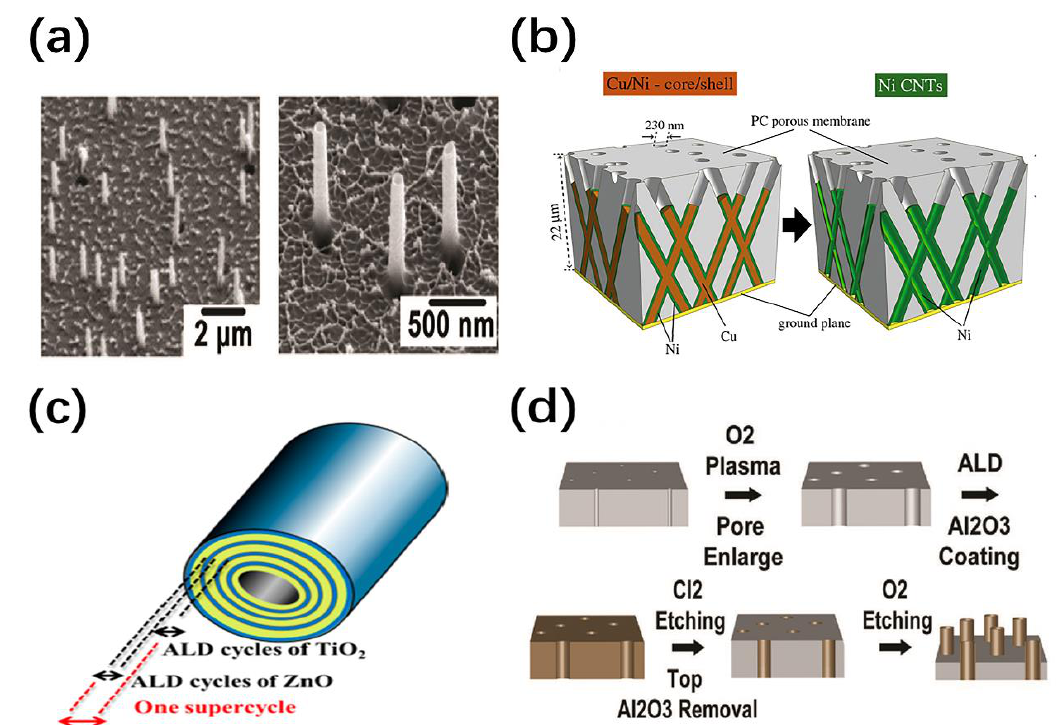
Figure 2. ( a ) SEM image of nanowires array [40]; ( b ) schematic illustration of 3-D Cu/Ni core/shell and Ni carbon nanotubes (CNTs) [41]; ( c ) schematic diagram of highly homogeneous Al- and Zn-doped TiO 2 nanotube by ALD with various cyclic sequences [43]; ( d ) schematic illustration of fabrication of nanostraws array using a track-etched polycarbonate membrane [40].